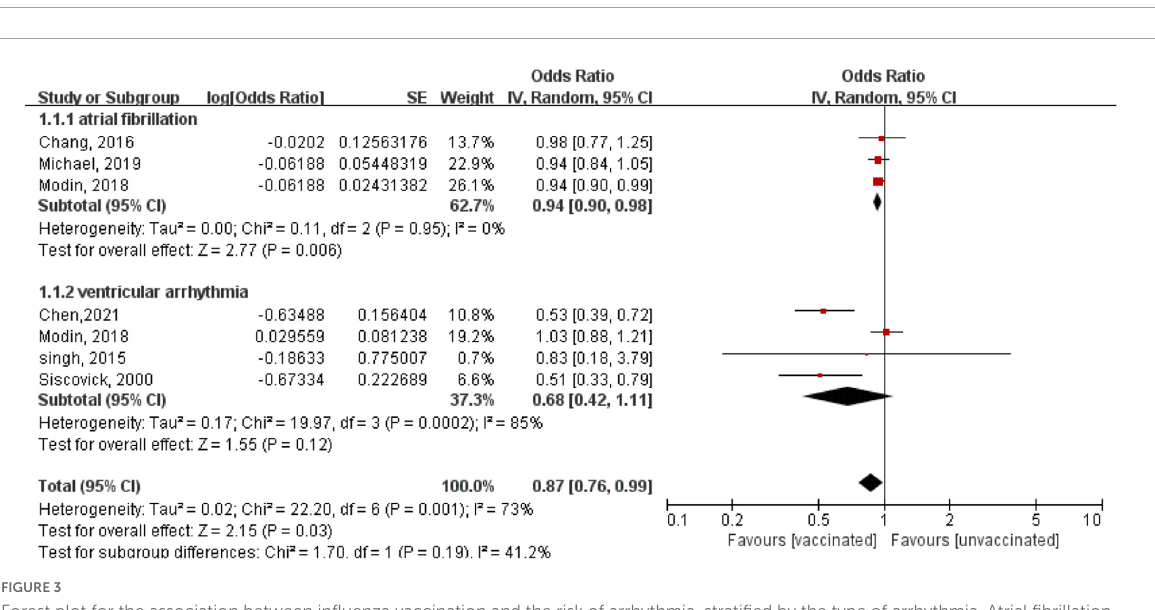
sample sizes are needed to assess the influenza vaccination- associated risk of